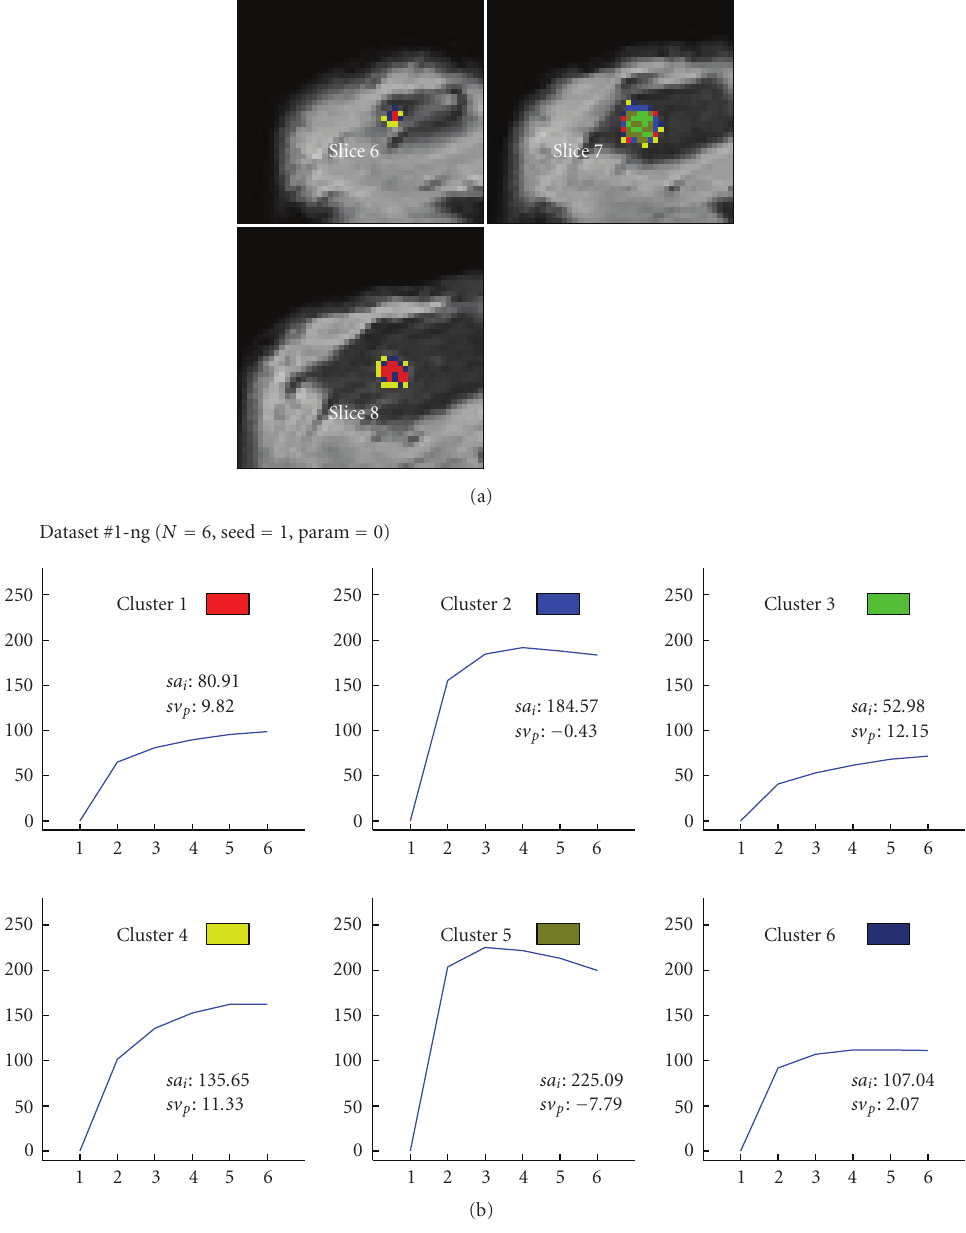
Figure 8: Segmentation method based on the “neural-gas” network applied to data set #1 (malignant lesion, DCIS) and resulting in six clusters. (a) shows the cluster distribution for each slice ranging from 6 to 8. (b) visualizes the representative time-signal intensity time curves for each